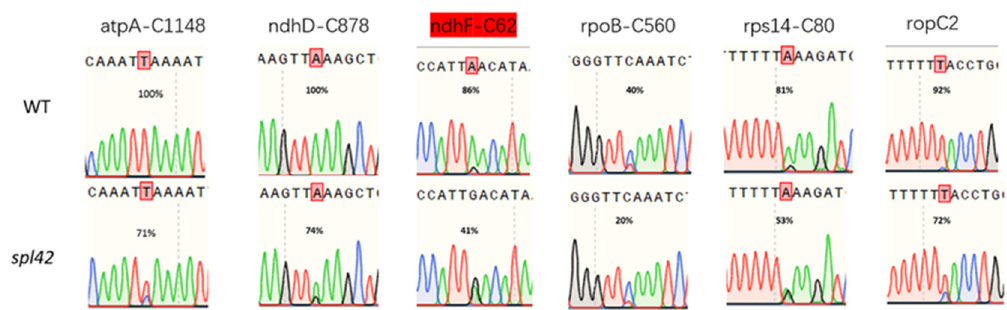
Figure A2. Changes in RNA editing efficiency in chloroplasts of the wild type and the spl42 mutant. The red box represents the only RNA editing site that changes amino acid of encoding protein.